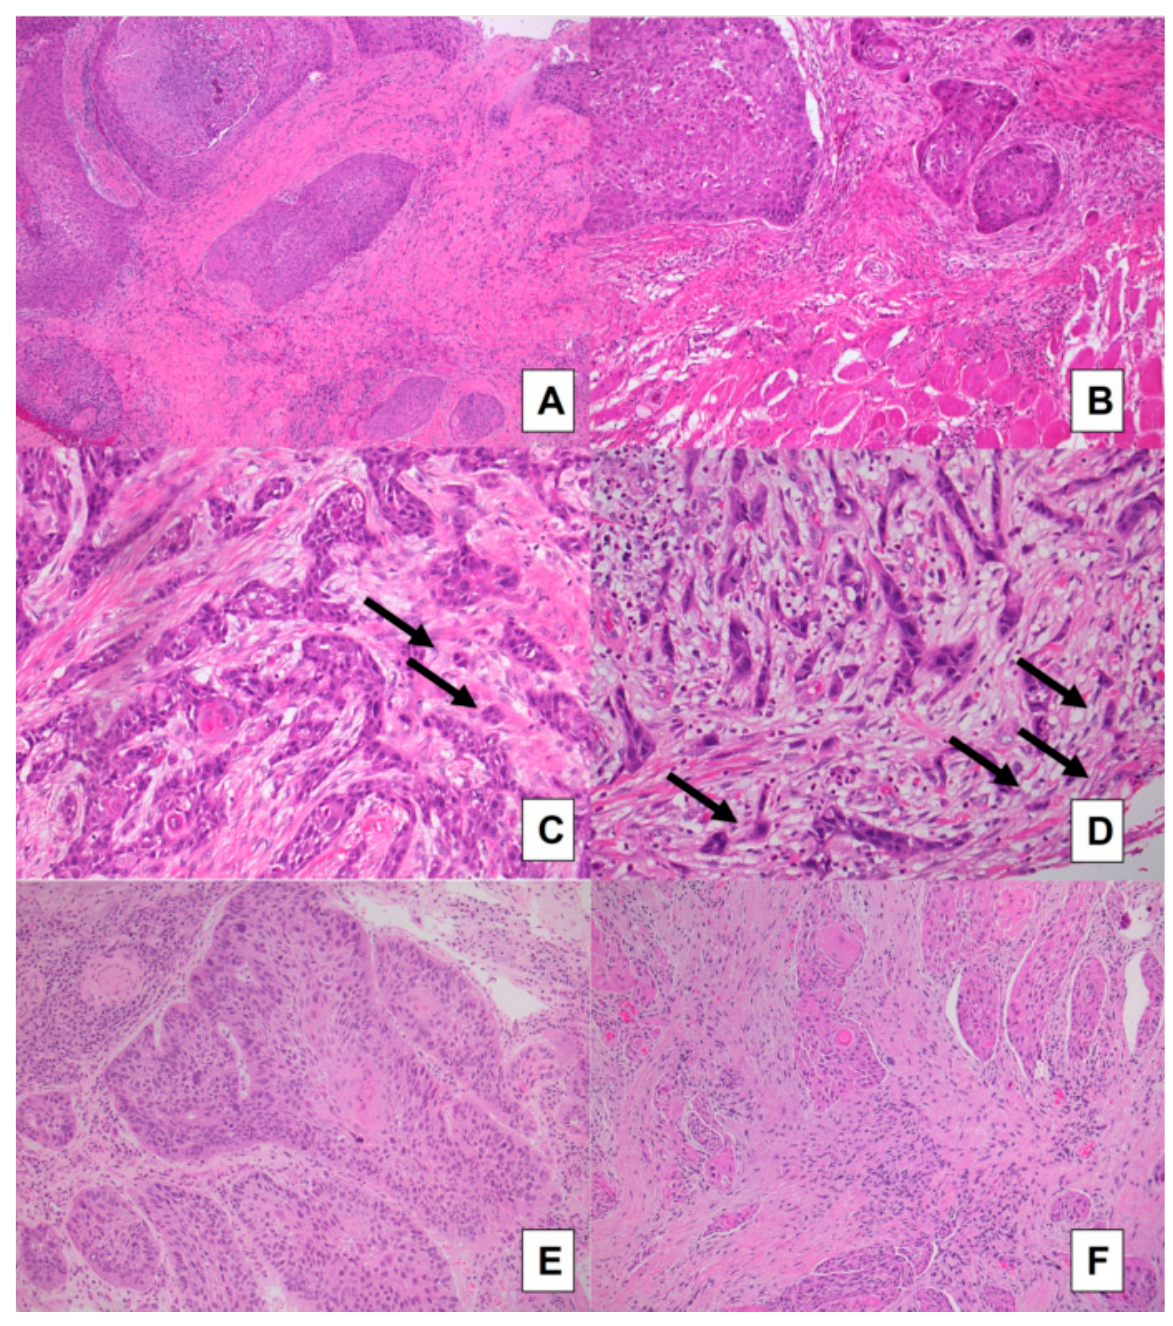
Figure 2. Conventional SCC cases: comparison between preoperative biopsies ( A , C , E ) and matched surgical samples ( B , D , F ). Concordance was good for the assessment of large neoplastic nests and very good for the evaluation of stroma type: a case with a more fibrotic stroma and large cell nests is evident in images ( A , B ), and a case with a more fibroblastic stroma is presented in images ( E , F ). Tumor buds are highlighted by black arrows in intratumoral stroma of a biopsy ( C ) and at the front of invasion in paired surgical specimen ( D ) (H&E stained slides; ( A , B , E , F ) original magnification 100×; ( C , D ) original magnification 200×).